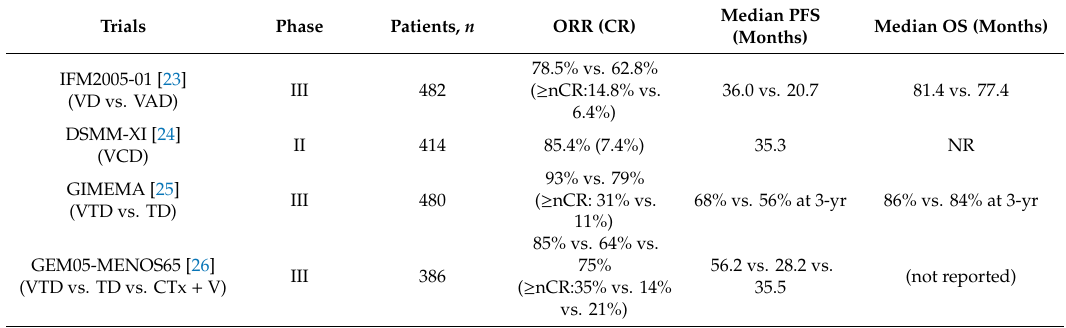
Table 2. Selected bortezomib-containing regimens for upfront treatment of transplant-eligible